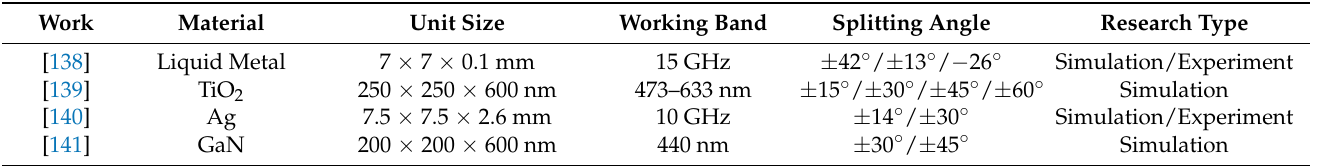
Figure 16. ( a ) The liquid metal is injected through the liquid inlet to form the TCE. Air can also be injected through the air inlet to adjust the length of the y–bar and x–bar [138]. Copyright 2018 John Wiley and Sons. ( b ) TCE array with x and y bars of different lengths [138]. Copyright 2018 John Wiley and Sons. ( c ) Simulation and simulation results of far-field intensity distribution of tunable polarization beam-splitting at different angles of − 42 ◦ ( i ), − 26 ◦ ( ii ) and 42 ◦ ( iii ) for y –polarized electromagnetic wave orientation with a fixed direction of 42 ◦ and x –polarized electromagnetic wave orientation. ( iv ) Far-field intensity distribution simulation and experimental results of x and y –polarized electromagnetic waves turning to the dynamic beam with the same angle of 42 ◦ , 13 ◦ , − 13 ◦ , − 42 ◦ , respectively. [138]. Copyright 2018 John Wiley and Sons. ( d ) Schematic diagram of the bilayer metasurface structure, and a schematic diagram of a unit cell [139]. ( e ) Transmission LCP and RCP light electric field distributions obtained under the normal incidence of x -polarized light with d = 1.46 ( i ), 2.82 ( ii ), 3.99 ( iii ), and 4.88 µ m ( iv ), as well as the far-field radiation pattern [139]. Table 8. Parameters of mechanical systems control tunable metasurface beam splitters described in this